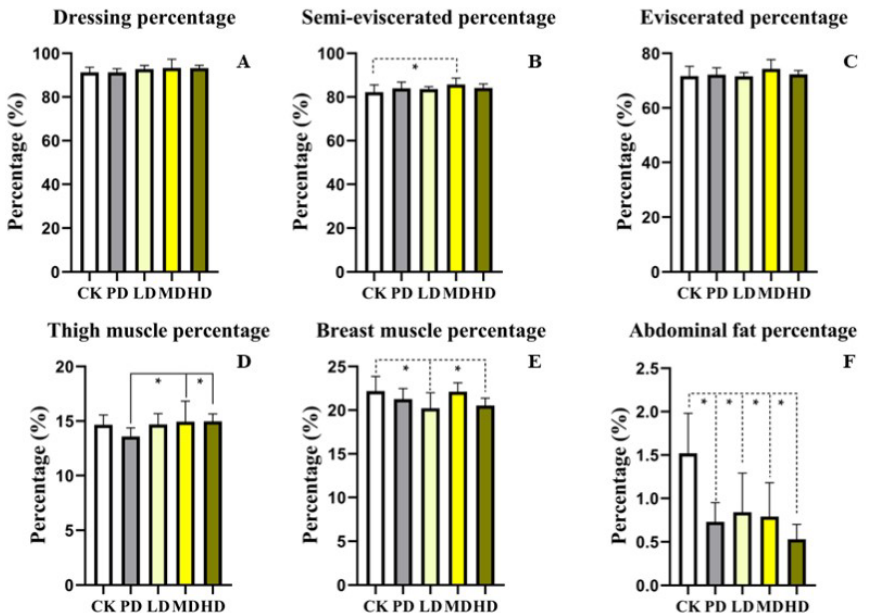
Figure 1. Effects of the fruit extract of K. coccinea on slaughter performance of white-feather broilers ( A ): Dressing percentage; ( B ): Semi-eviscerated percentage; ( C ): Eviscerated percentage; ( D ): Thigh muscle percentage; ( E ): Breast muscle percentage; ( F ): Abdominal fat percentage. Note: Dotted line: compare with CK group; Solid line: compare with PD group; * indicate significant differences between groups according to the Tukey test; Supplementary Materials Table S1.